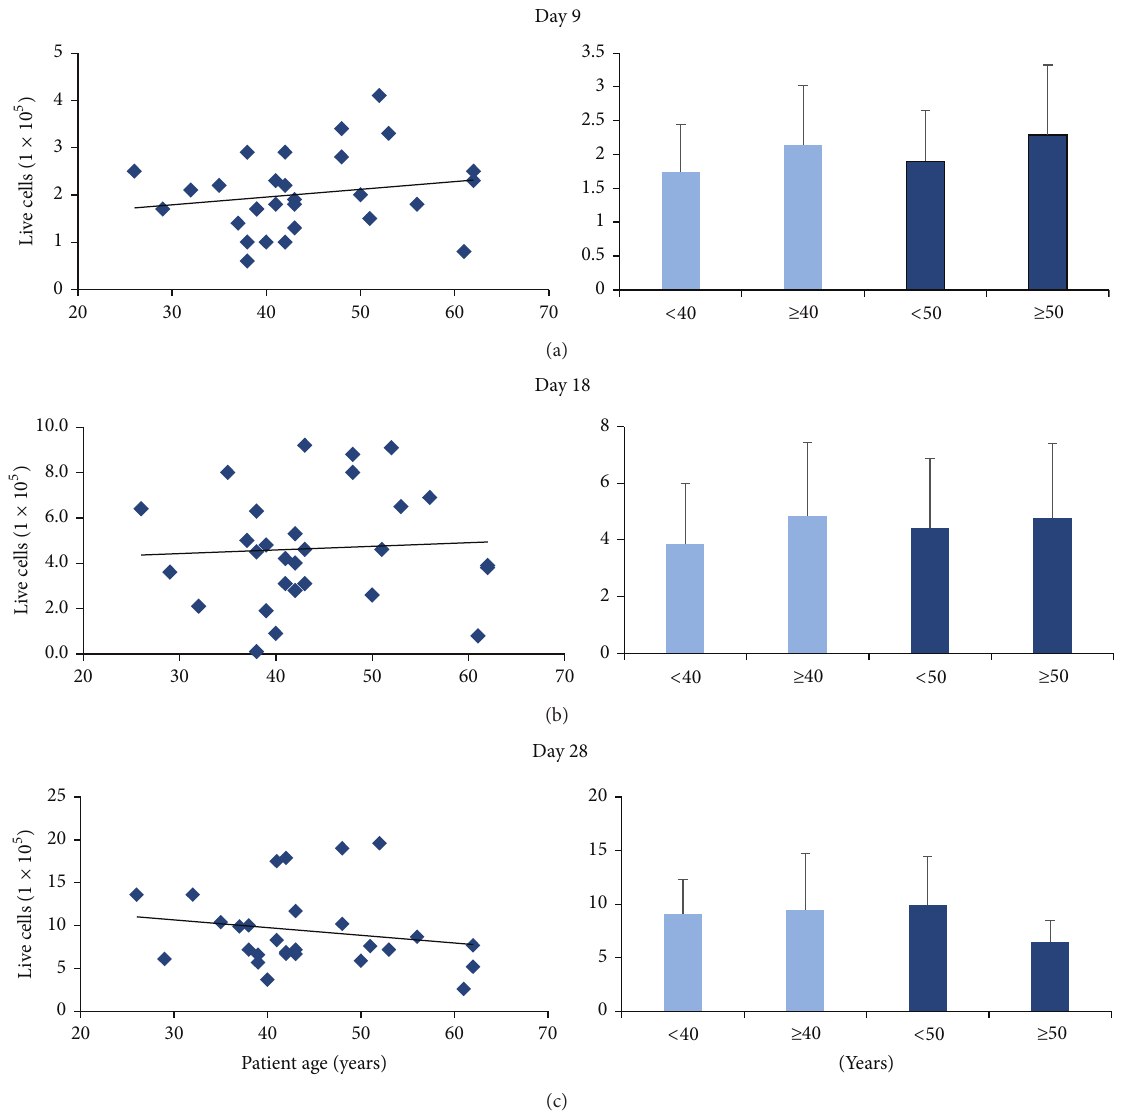
Figure 6: Live ASCs during extended cell growth relative to patient age. ASCs from each patient were plated to a density of 1 × 10 5 cells/well and viability was assayed after (a) 9, (b) 18, and (c) 28 days to characterize the effect of patient age on continued ASC viability. We observed sustained ASC viability irrespective of patient age. Cell counts were compared relative to patients across 4 cohort groups: < 40 years ( 𝑁 = 12 ) versus ≥ 40 years ( 𝑁 = 20 ); < 50 years ( 𝑁 = 23 ) versus ≥ 50 years ( 𝑁 = 9 ); and < 40 years ( 𝑁 = 12 ) versus ≥ 50 years ( 𝑁 = 9 ). Live cell number was not found to be significantly different in any of the